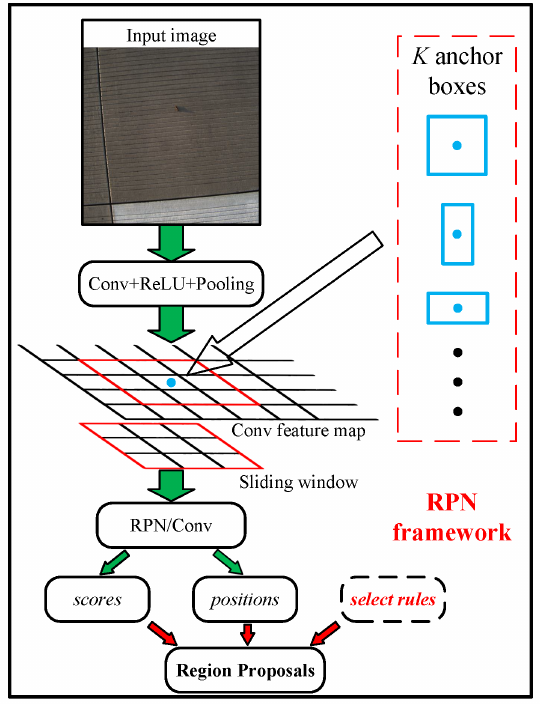
Figure 2. The RPN framework for FOD